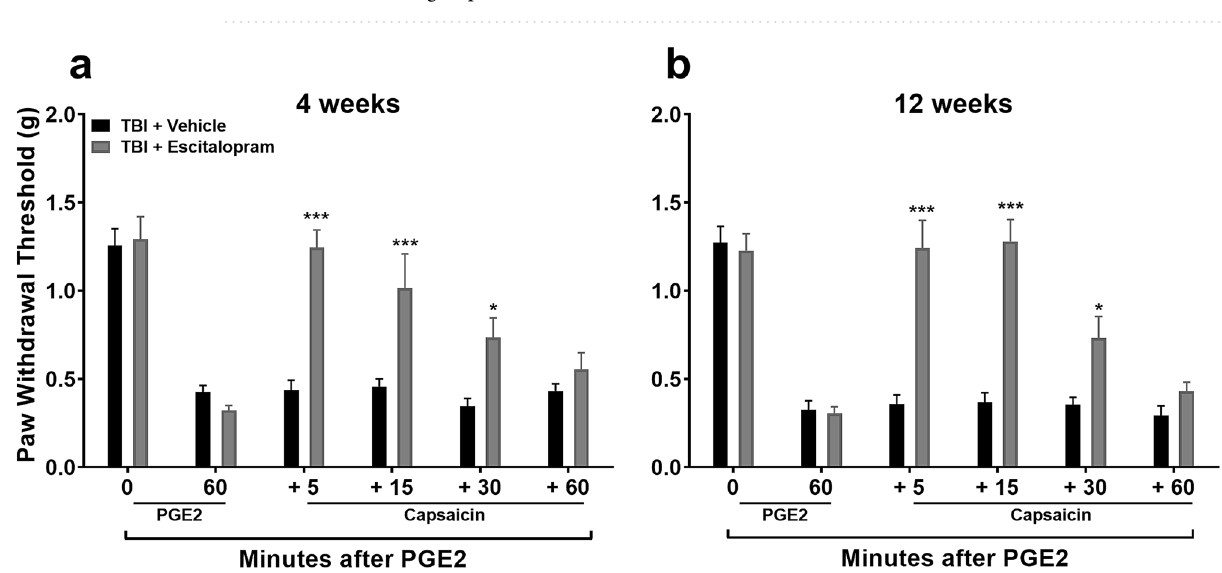
Figure 7. Assessment of diffuse noxious inhibitory control (DNIC) response after duloxetine (DUL) treatment. Systemic pre-treatment with DUL (10 mg/kg, s.c for 3 days), a serotonin and norepinephrine reuptake inhibitor, is effective in restoring the DNIC response at either 4 (a ) or 12 ( b ) weeks post TBI in male mice. The last dose of DUL was given 18 h prior to testing to avoid its acute analgesic effects on PGE-2 application. Data were analyzed by two-way repeated measures ANOVA using the Sidak multiple comparisons test to correct for multiple comparisons. * p < 0.05, *** p < 0.001 indicates significant difference between vehicle and drug treatment groups. Error bars: SEM, n = 6/group.